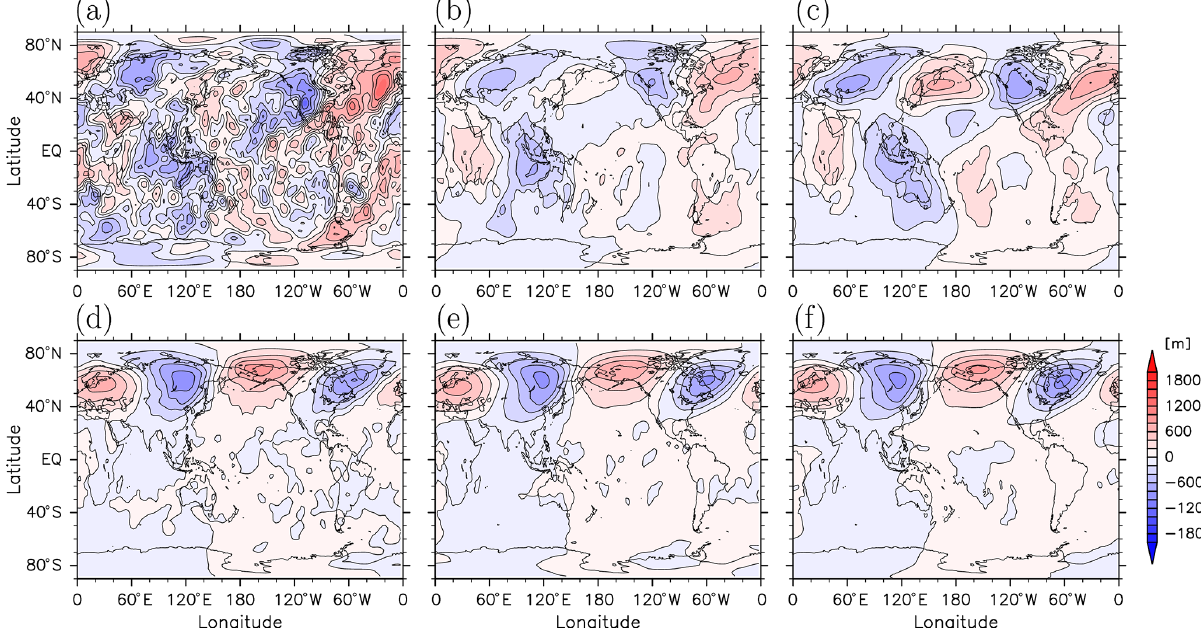
Figure 2. (a–c) The longitude–latitude sections of the geopotential height anomaly from the zonal mean in 00:00UTC on 20 January 2017 at 0.1hPa from (a) the Ctrl (KSMW20) analysis, (b) the analysis with the IAU (Expt. I), and (c) the MERRA-2 reanalysis. The contour intervals are 200m. (d–f) Same as (a–c) but for 10hPa.